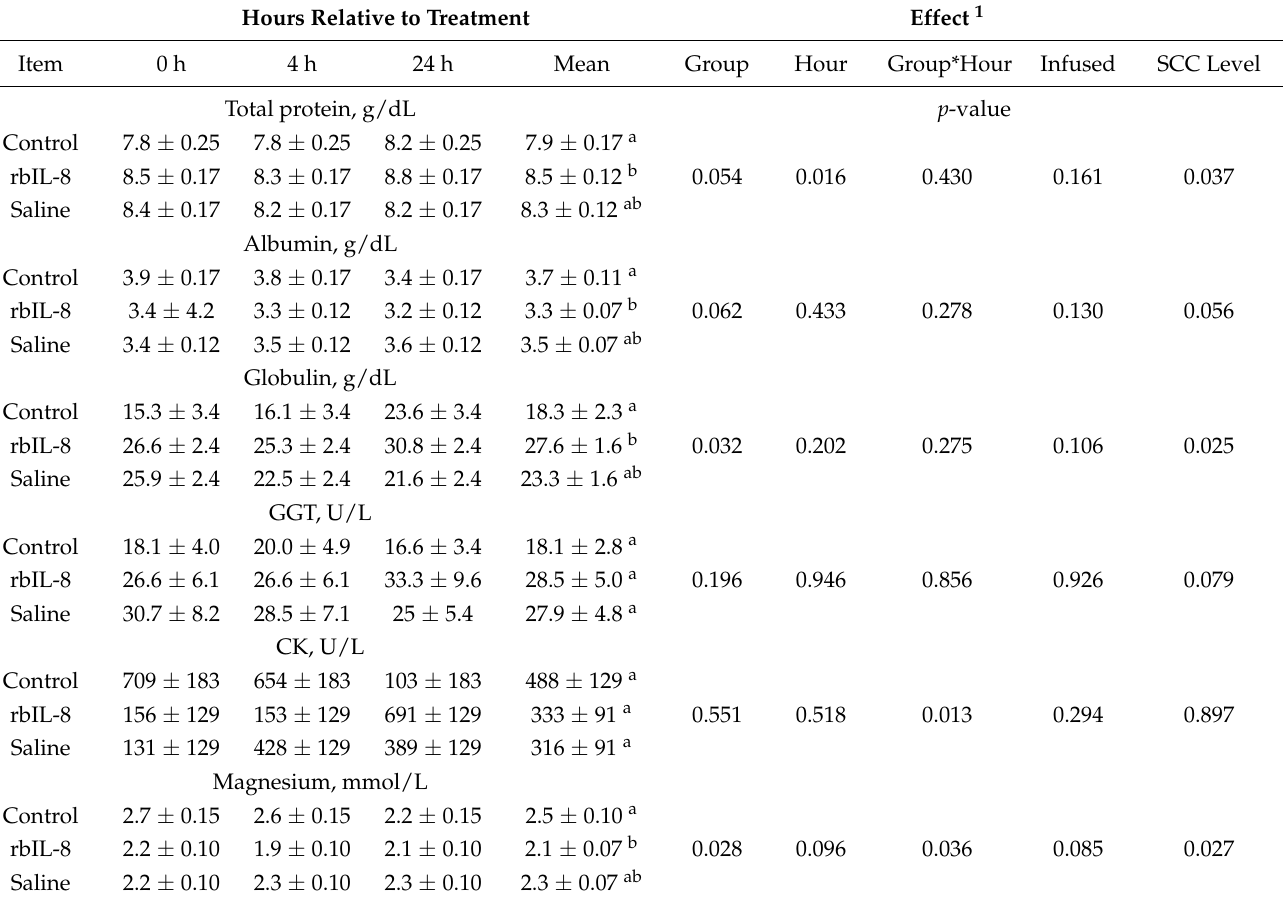
Table 3. Biochemical profile among groups and hours relative to